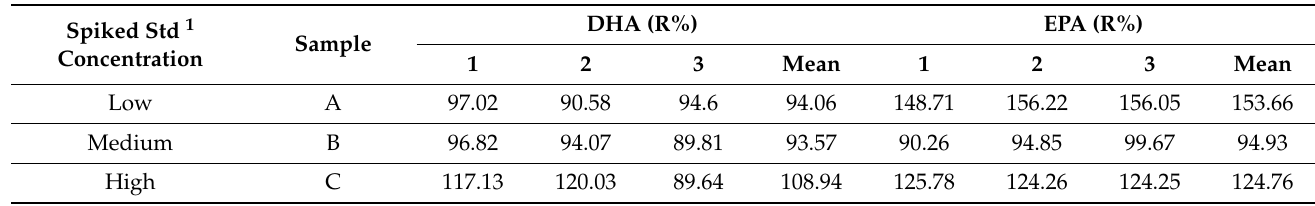
Table 4. Recovery factor (R%) at three additional levels for the three studied